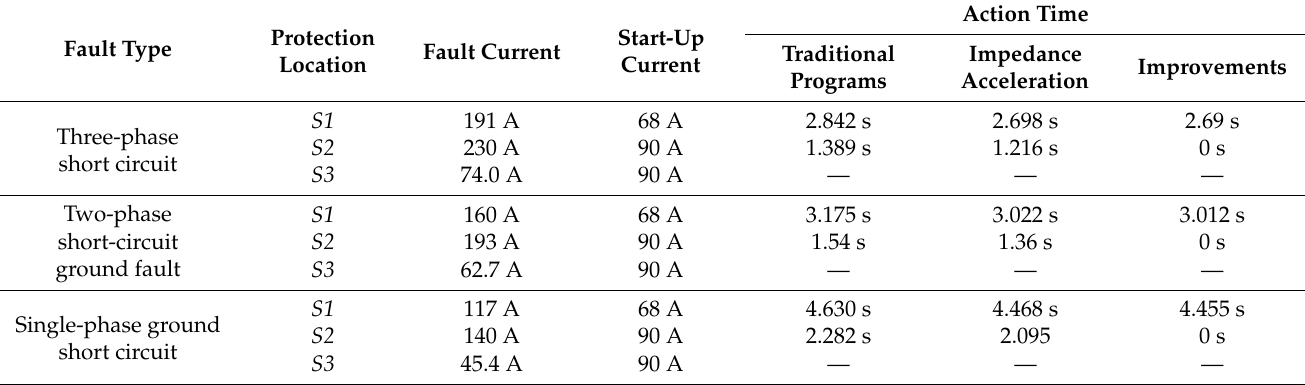
Table 7. Operating time of different protection schemes in the case of line BC via 50 Ω ground resistance fault.